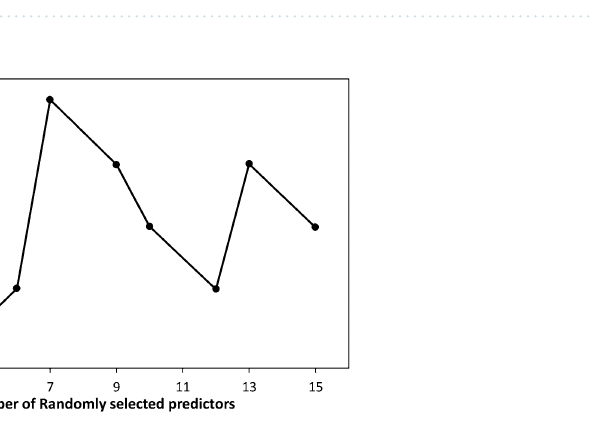
Table 1. Values of the tuning parameter, k and the corresponding accuracy and kappa statistics for the kNN model on the training dataset.